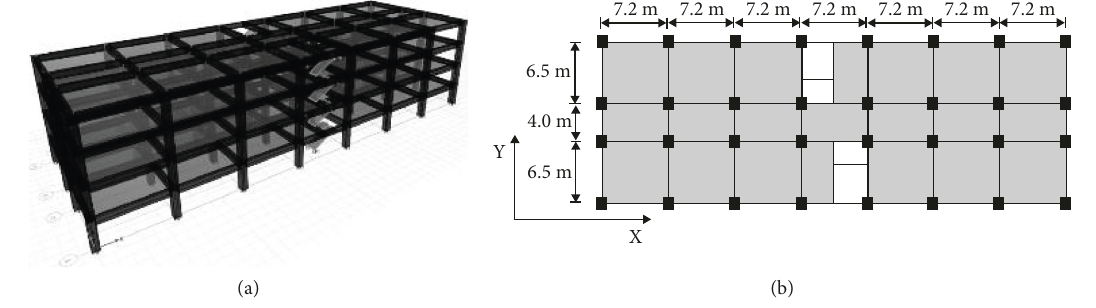
Figure 5: Prototype hospital building. (a) 3D view. (b) Plan